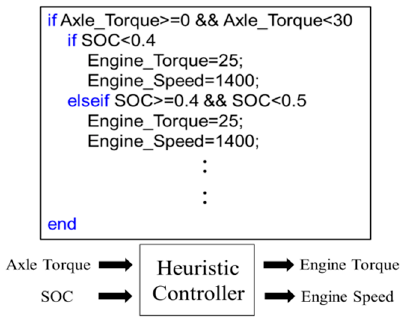
Figure 9. Heuristic controller.